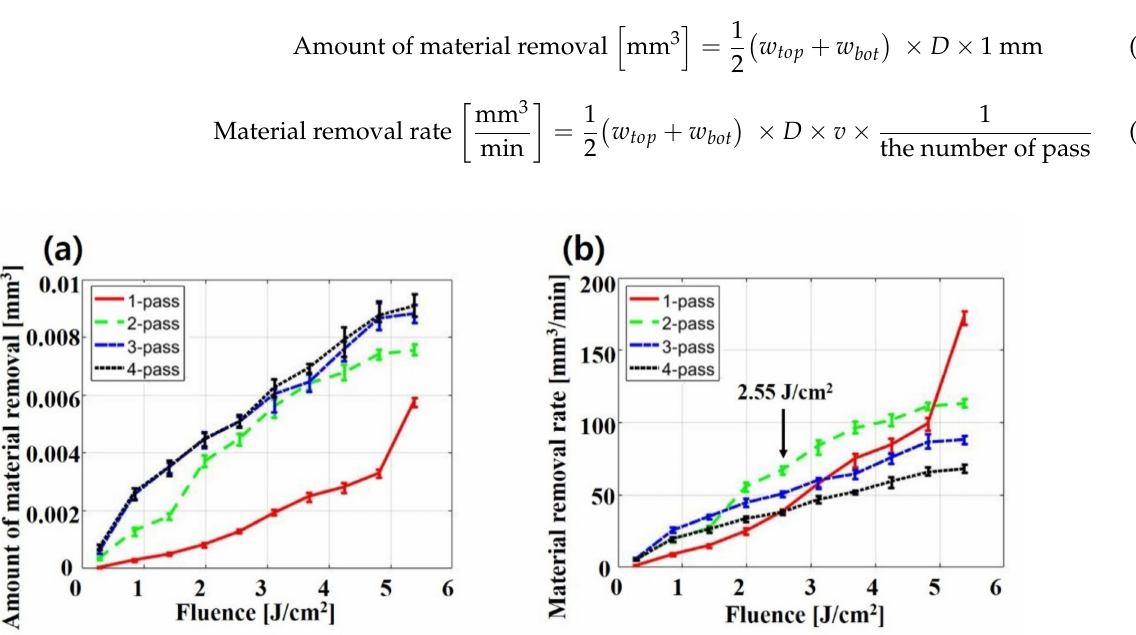
Figure 7. ( a ) Amount of material removal (AMR) and ( b ) material removal rate (MRR) depending on laser